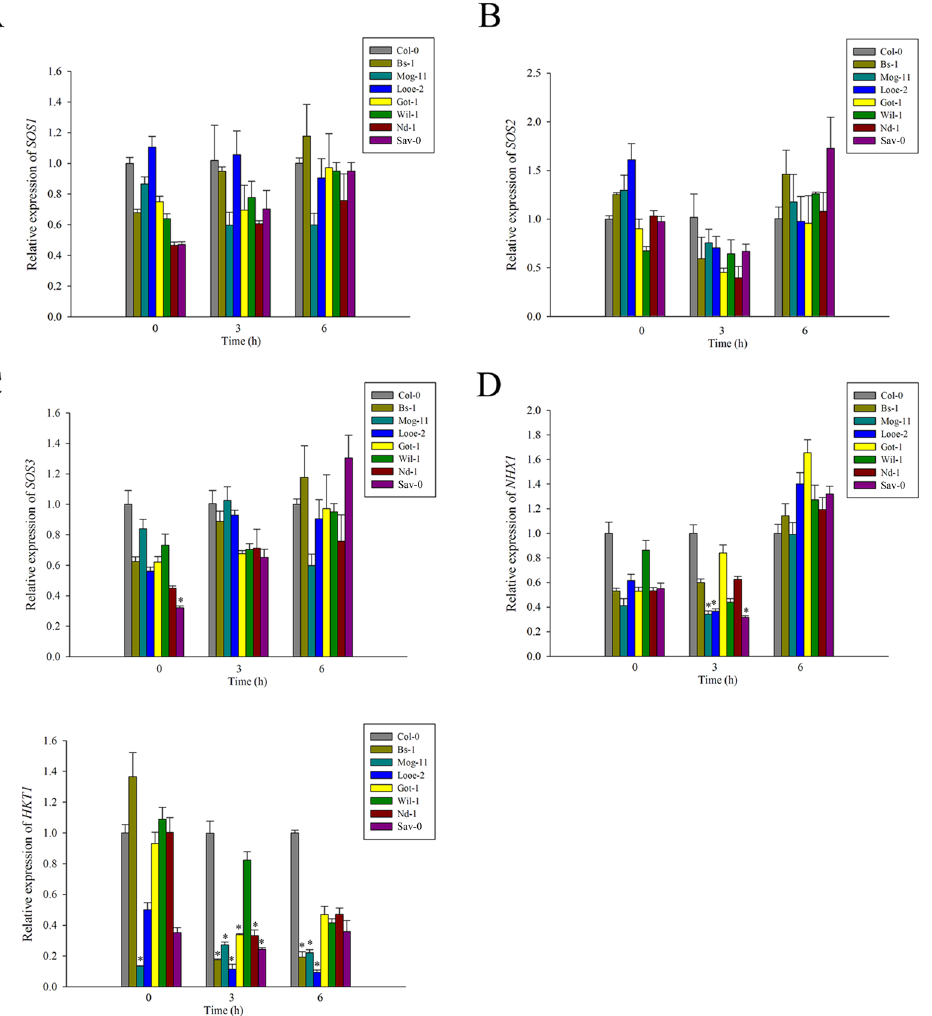
Fig 4. Expression analysis of genes related to Na + transport by qRT-PCR. The transcript levels of (A) SOS1 , (B) SOS2 , (C) SOS3 , (D) NHX1 and (E) HKT1;1 in Col-0 and the selected accessions exposed to 100 mM NaCl for 0, 3 and 6 h. Values given as mean ± SE (n = 3). Significant differences from Col-0 accession at the same time point are indicated by * ( P <